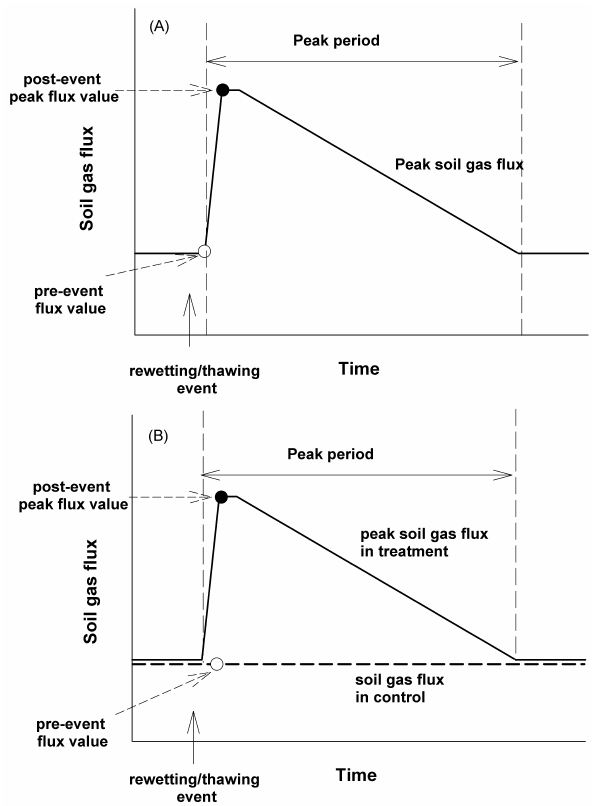
Fig. 1. Simplified hypothetical figures representing peak soil gas flux in rewetting of dry soils and thawing of frozen soils and peak flux period. Peak gas flux occurred in natural rewetting or thawing event (solid line) and pre-event flux value (white dot) and post-event peak flux value (black dot) used to determine flux change rate (A) ; peak gas flux occurred in rewetting or thawing treatment (solid line) and gas flux in control (dot line) and pre-event flux value (white dot, the flux value in control when post-event peak flux value is read) and post-event flux value (black dot) used to determine flux change rate (B) . The figure is a simplification of the response and does not reflect the full dynamics of a pulse response as shown in Fig.